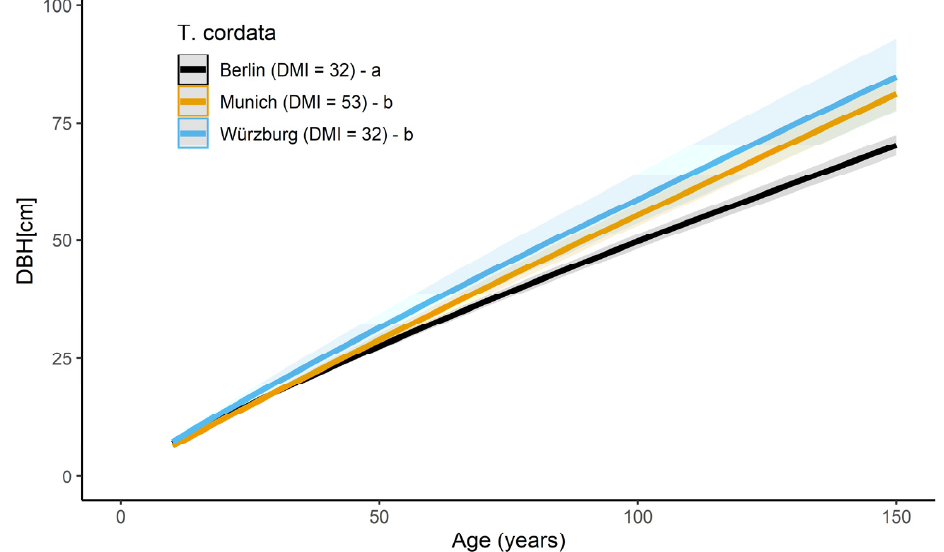
Figure 5. Stem diameter growth in dependence of age of T. cordata in Berlin (black curve, N = 251 trees), Munich (orange curve, N = 133 trees), and Würzburg (blue curve, N = 30 trees). Letters a and b show significant differences between the slopes. The shaded bands visualize the prediction confidence interval of the curves.